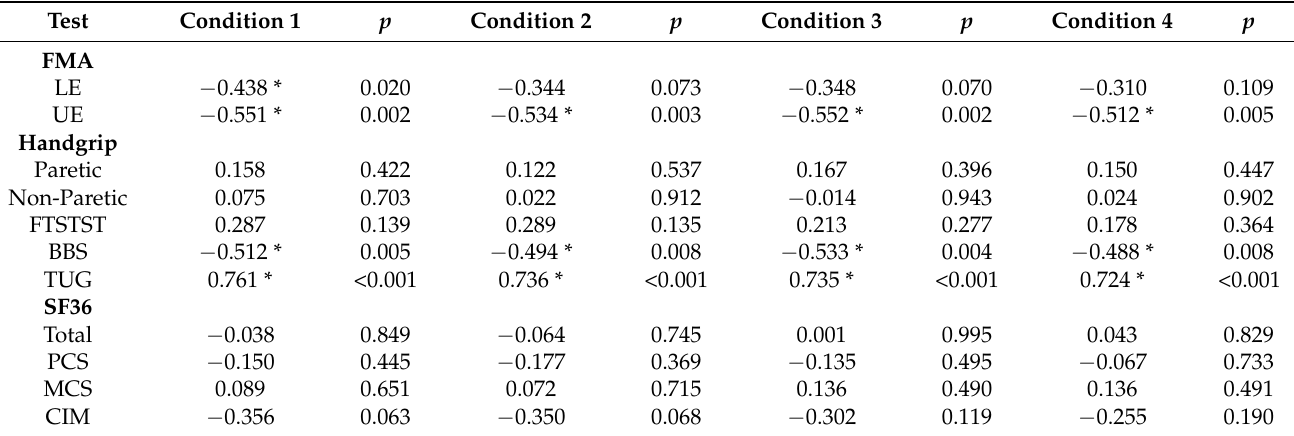
Table 4. Correlation of L Test Completion Time with other Stroke-Specific Outcome